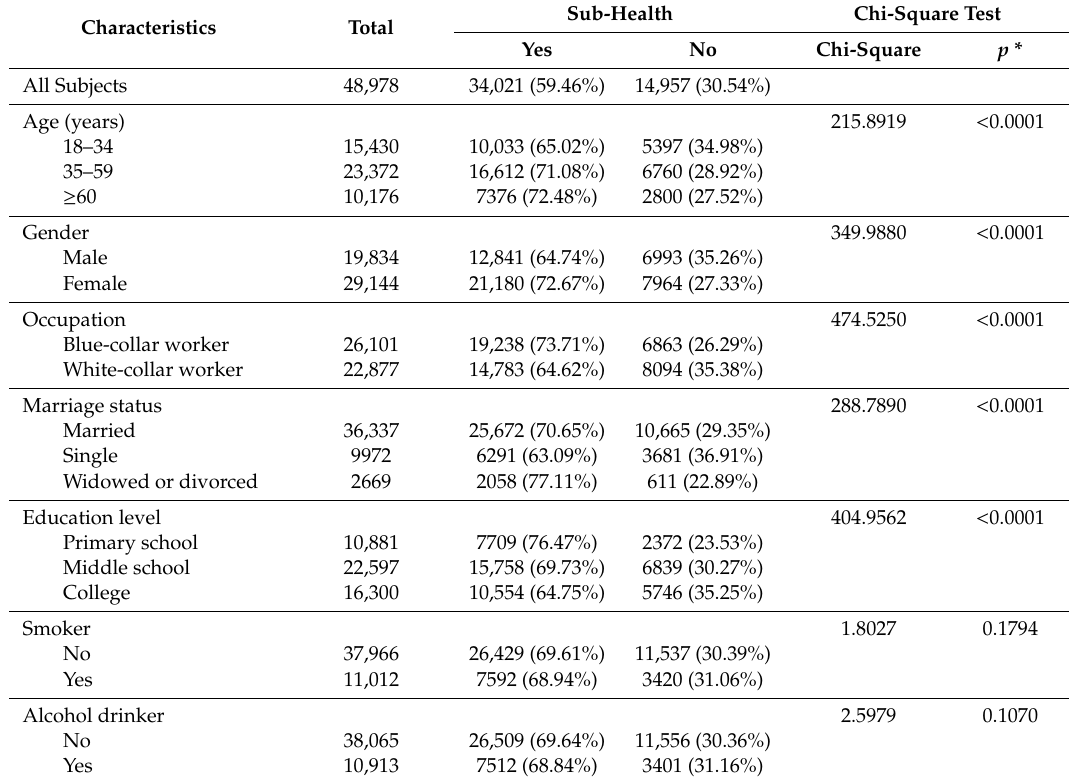
Table 2. Prevalence (%) of suboptimal health by respondents’ demographic